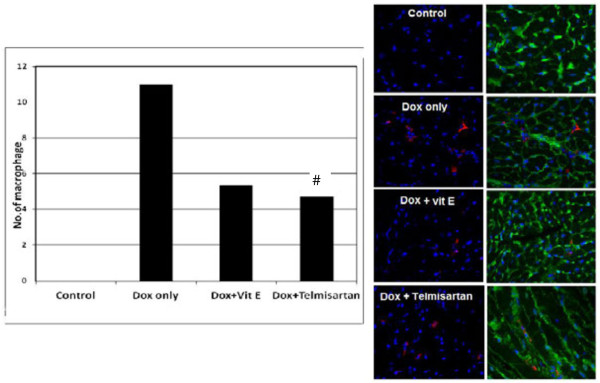
Immunofluorescent staining demonstrates that Dox treatment only group of rat exhibit greater macrophages infiltration than vitamin E and telmisartan group. Data are expressed as mean ± SEM. #P < 0.05; vs. Dox only group (n = 8 per group).